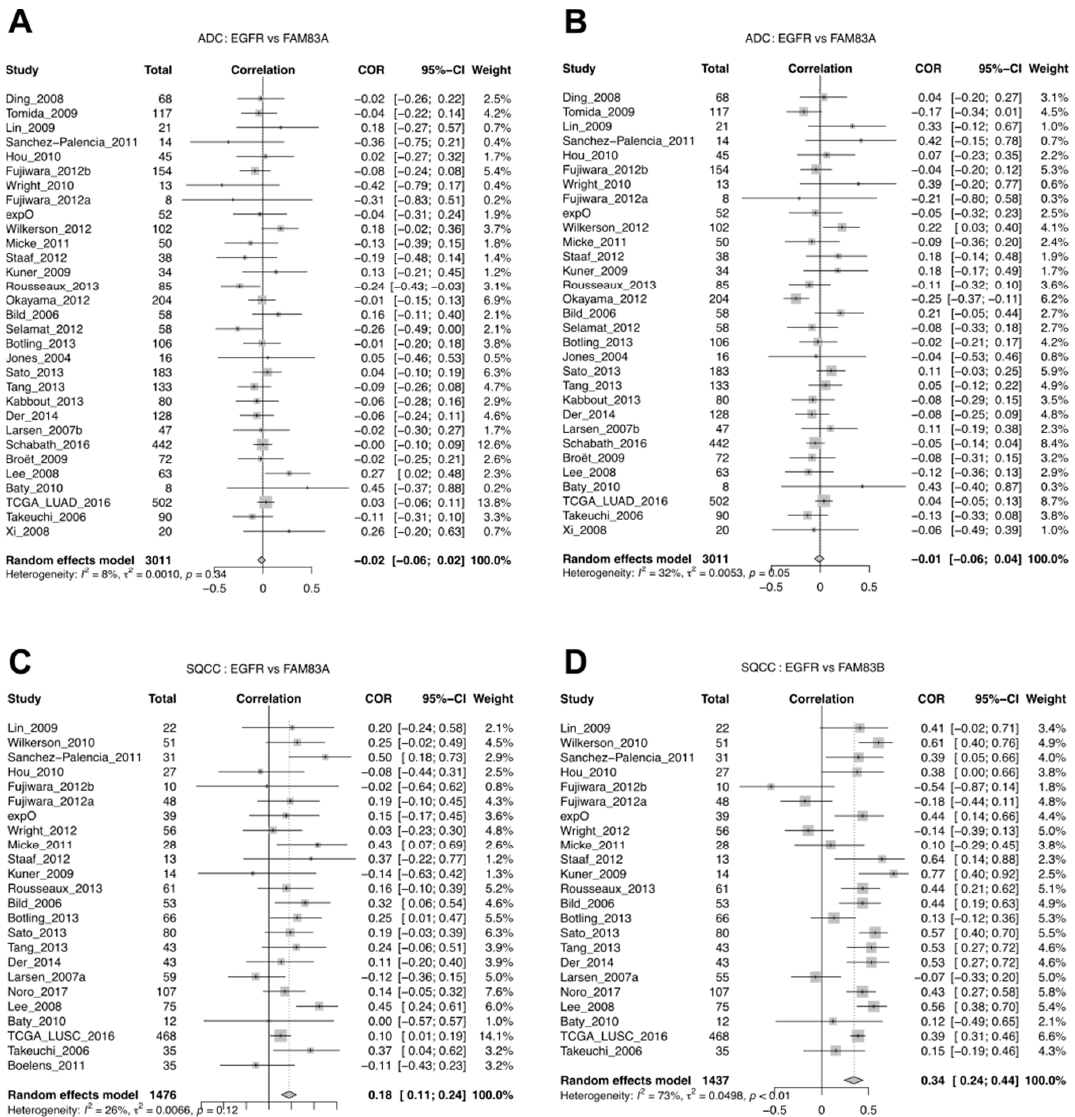
Figure 7. Meta-analysis of correlation in ADC and SQCC for FAM83A and B vs. EGFR expression. ( A ) Forest plot for the correlation between FAM83A and EGFR in ADC. ( B ) Forest plot for the correlation between FAM83B and EGFR in ADC. ( C ) Forest plot for the correlation between FAM83A and EGFR in SQC. ( D ) Forest plot for the correlation between FAM83B and EGFR in SQC.